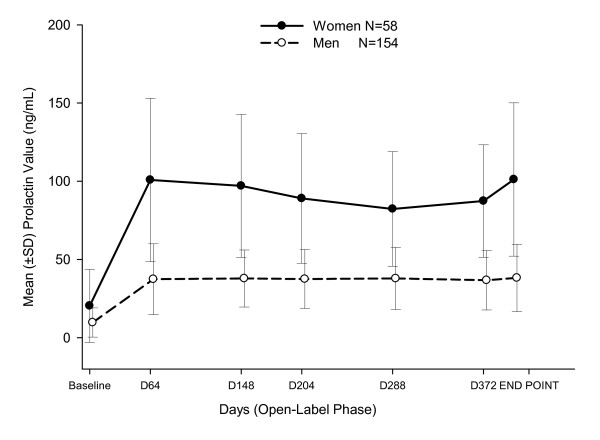
Mean changes in prolactin overtime.